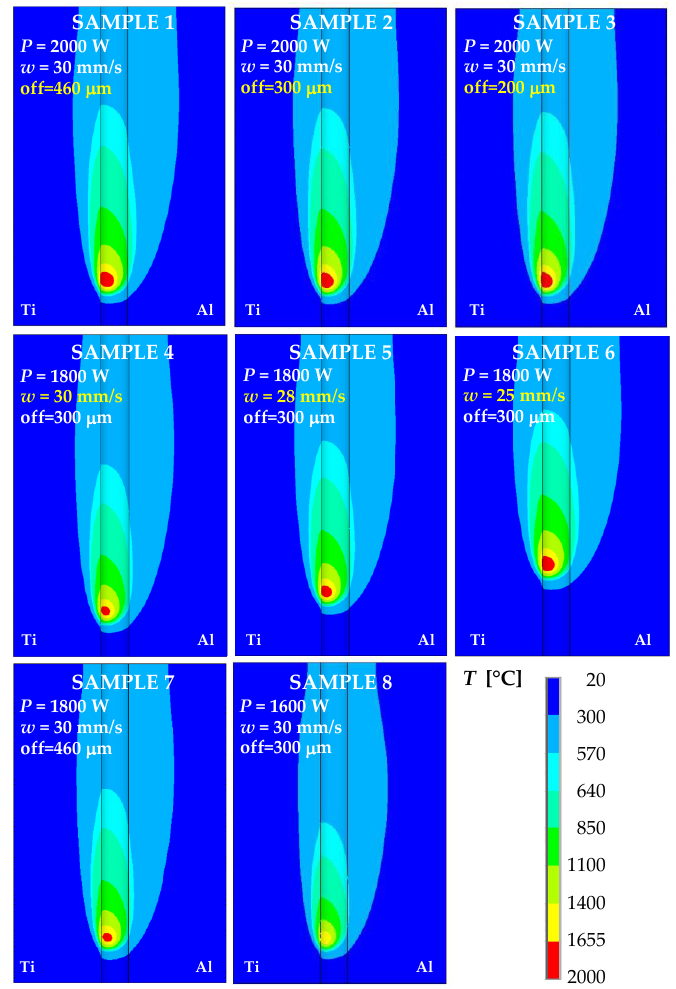
Figure 8. Details of the temperature fields at the time of 1 s for samples 1 to 8 computed using different welding parameters according to Table 4.